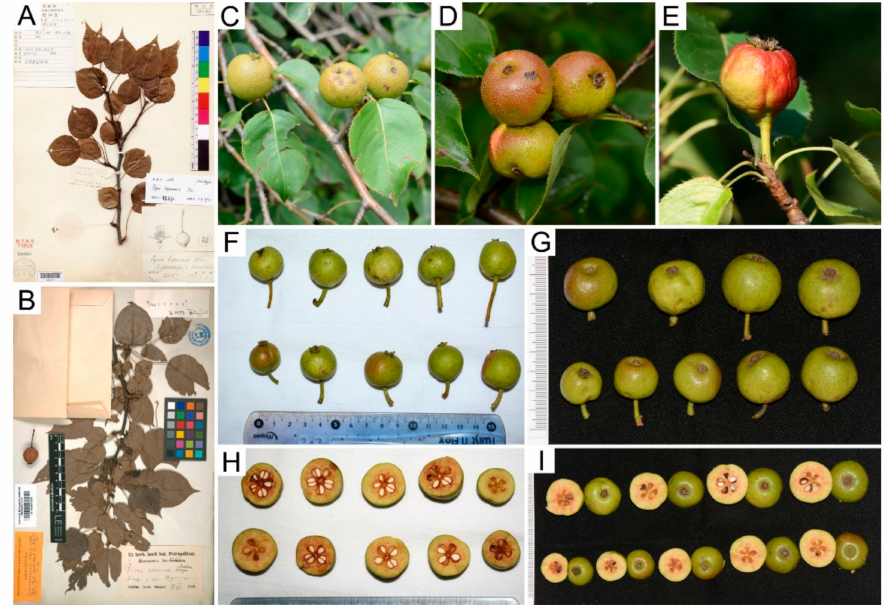
Figure 3. Type specimens of Pyrus hopeiensis and P. ussuriensis and fruit morphological characteristics of P. ussuriensis populations in North China. ( A ) Holotype of P. hopeiensis , ( B ) lectotype of P. ussuriensis ,